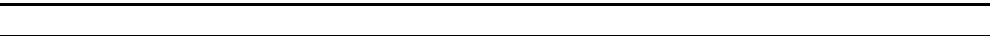
Table 3. Irrigation quotas and irrigation efficiency under SUI and FLI (CK1).